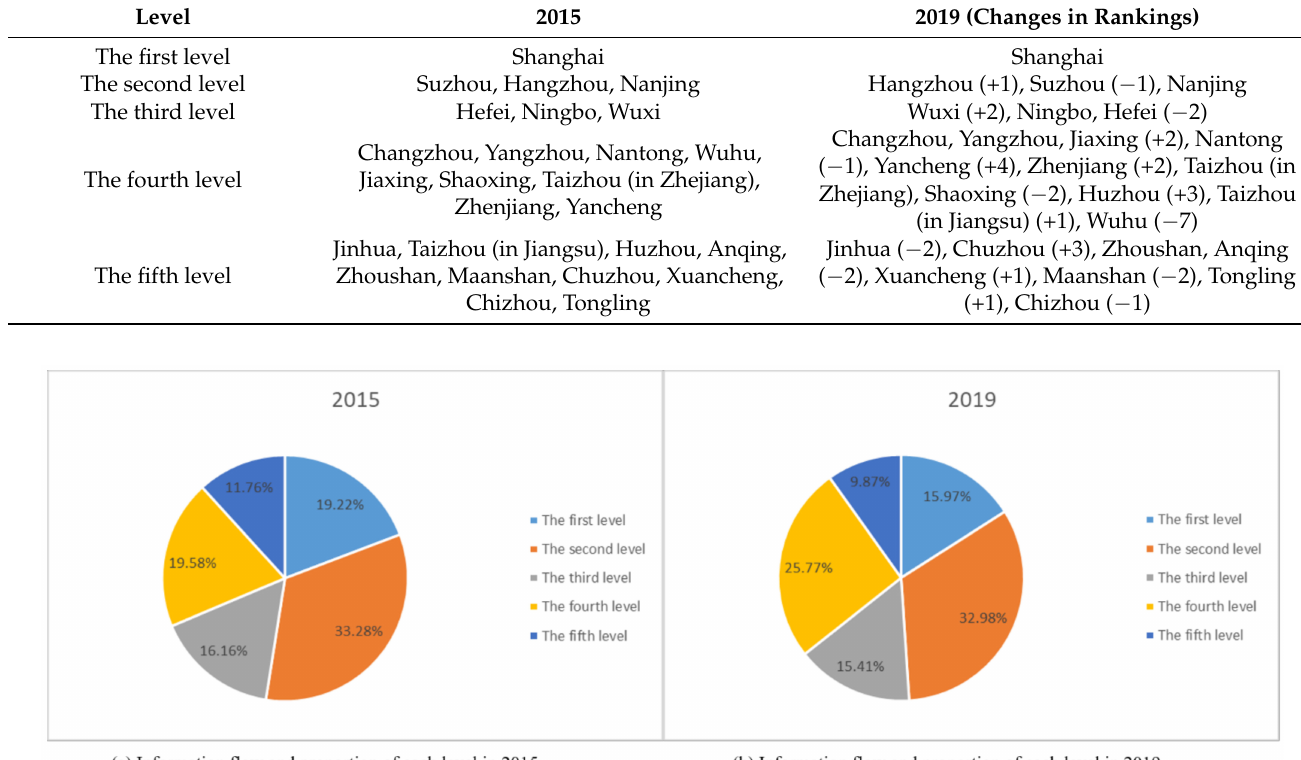
Table 1. Network hierarchy distribution.